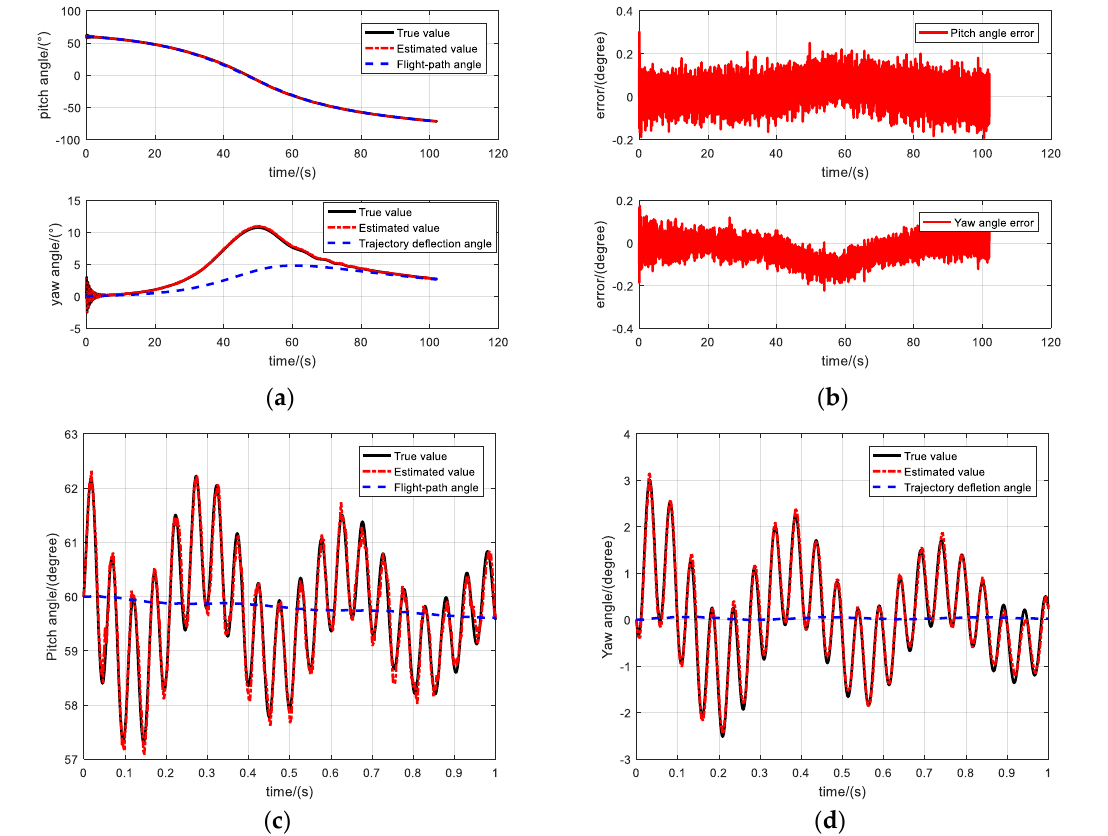
Figure 7. Estimated and true values of pitch and yaws. ( a ) Estimation of the pitch and yaw angles in the entire ballistic, ( b ) Estimation error of the pitch and yaw angles, ( c ) Estimation of the pitch angle within 1 s of the initial phase of ballistic, ( d ) Estimation of the yaw angle within 1 s of the initial phase of ballistic.